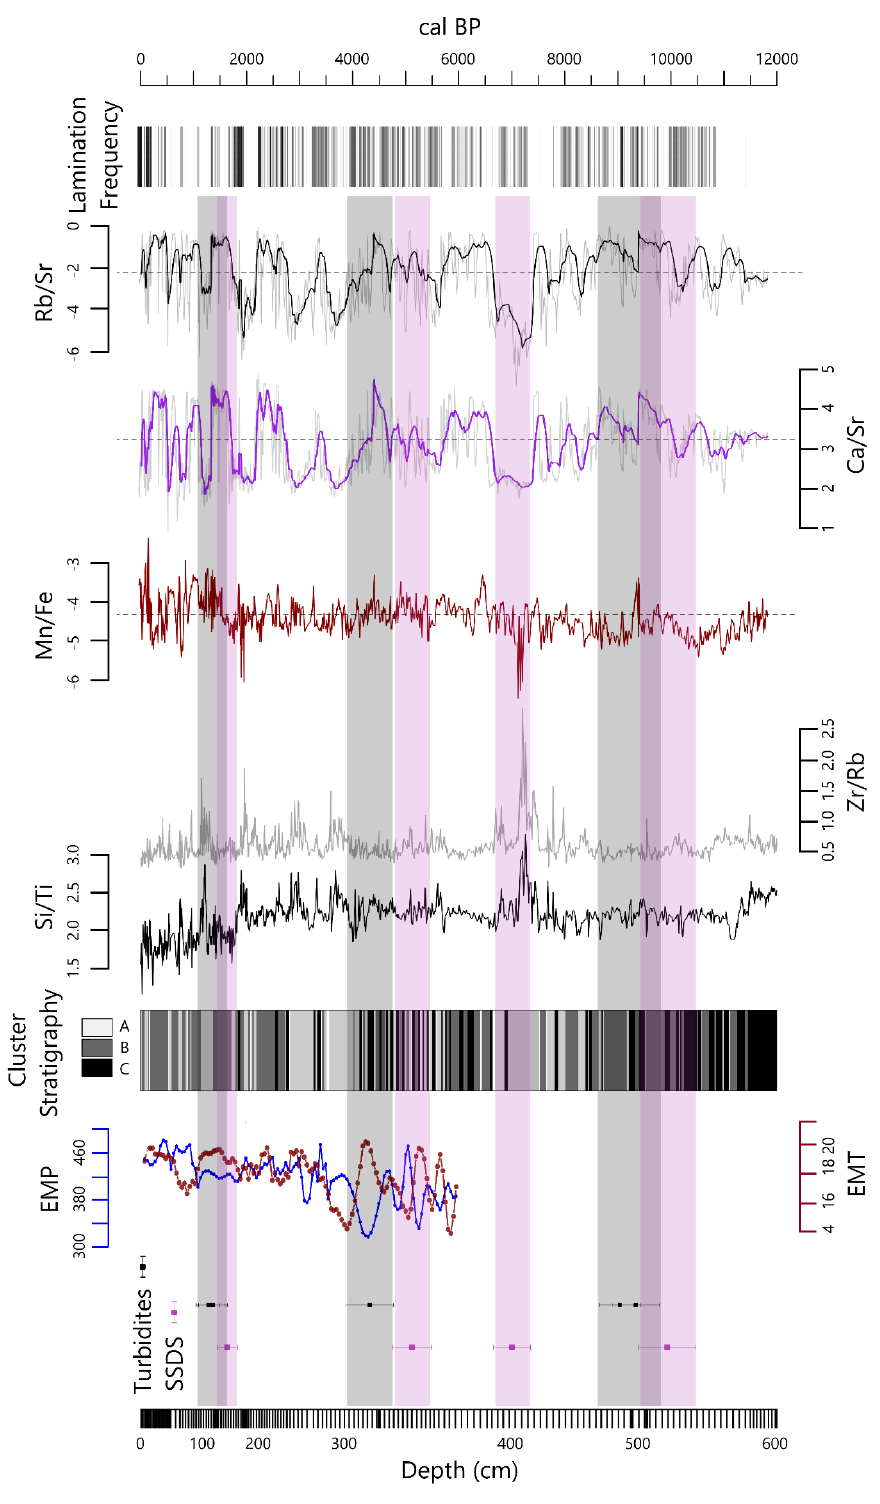
Figure 8. Multi-proxy diagram including geochemical profiles of Rb / Sr Ca / Sr, Mn / Fe, Zr / Rb and Si / Ti, lamination frequency as measured through CT analysis, clustering stratigraphy exported through the constructed heatmap, Eastern Mediterranean precipitation and temperature model for mid- to late-Holocene as suggested by [137] and Turbidite deposits, as well as SSDS, recognized in the core. Turbidite deposits and SSDS were assigned with additional 2 σ error as suggested by the age-depth